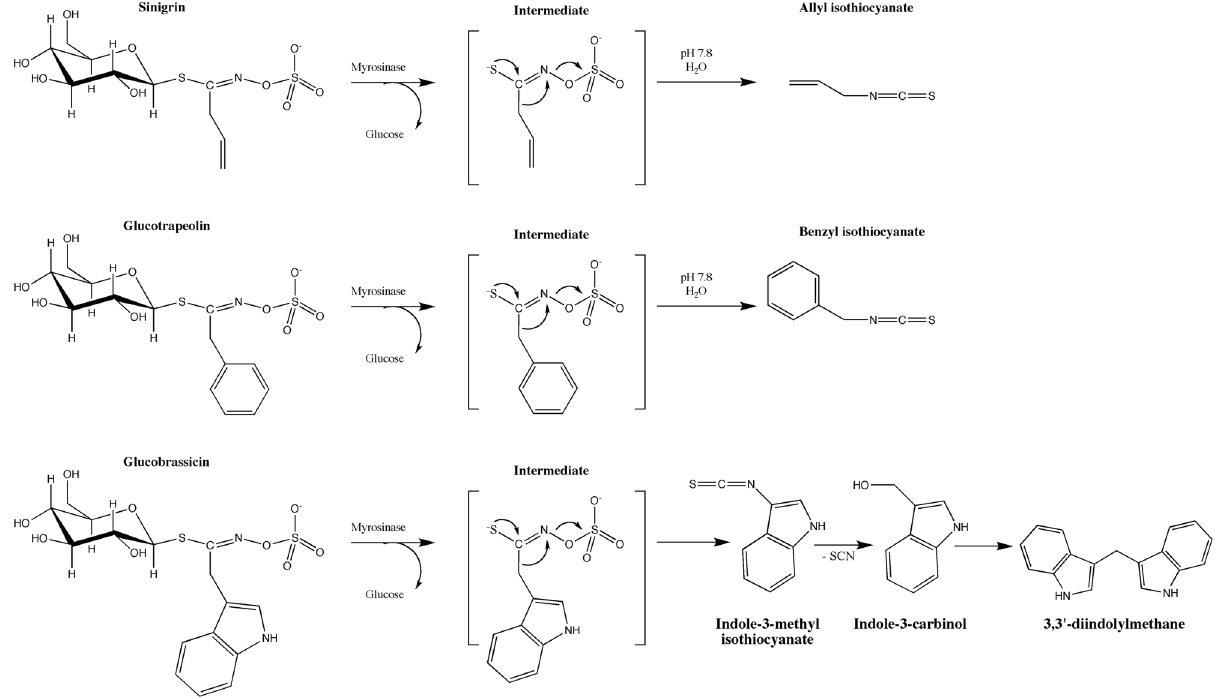
Figure 1. Glucosinolates studied and their degradation products.